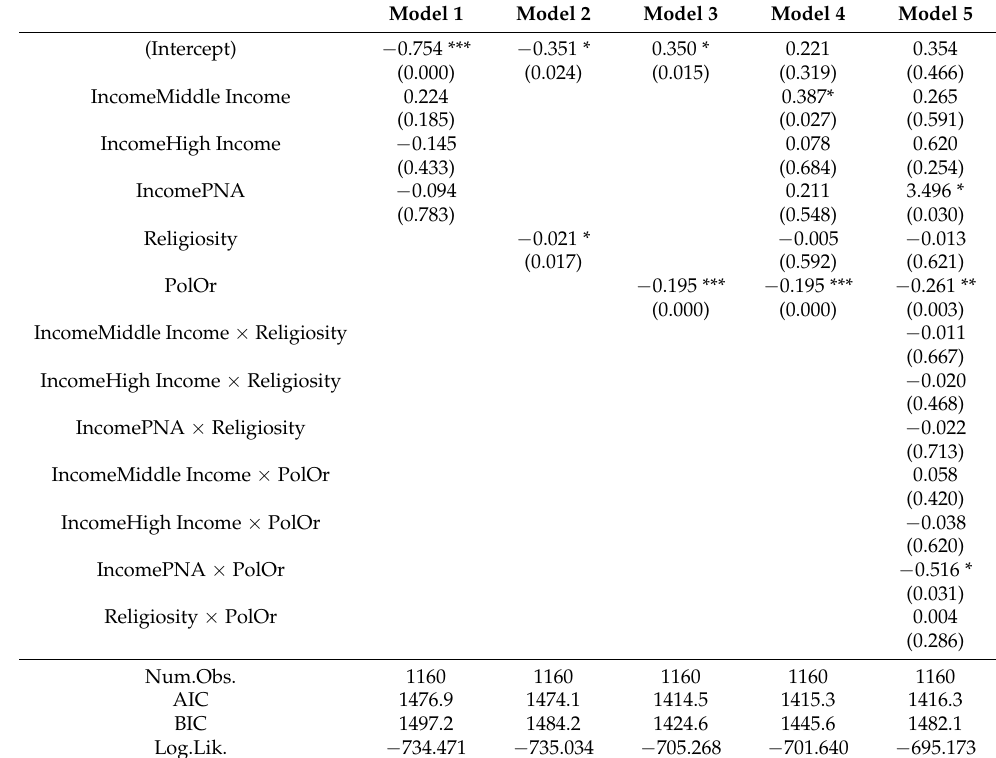
Table 5. The effects of income, religiosity, and political orientation on perception of long-term health risks from air pollution.